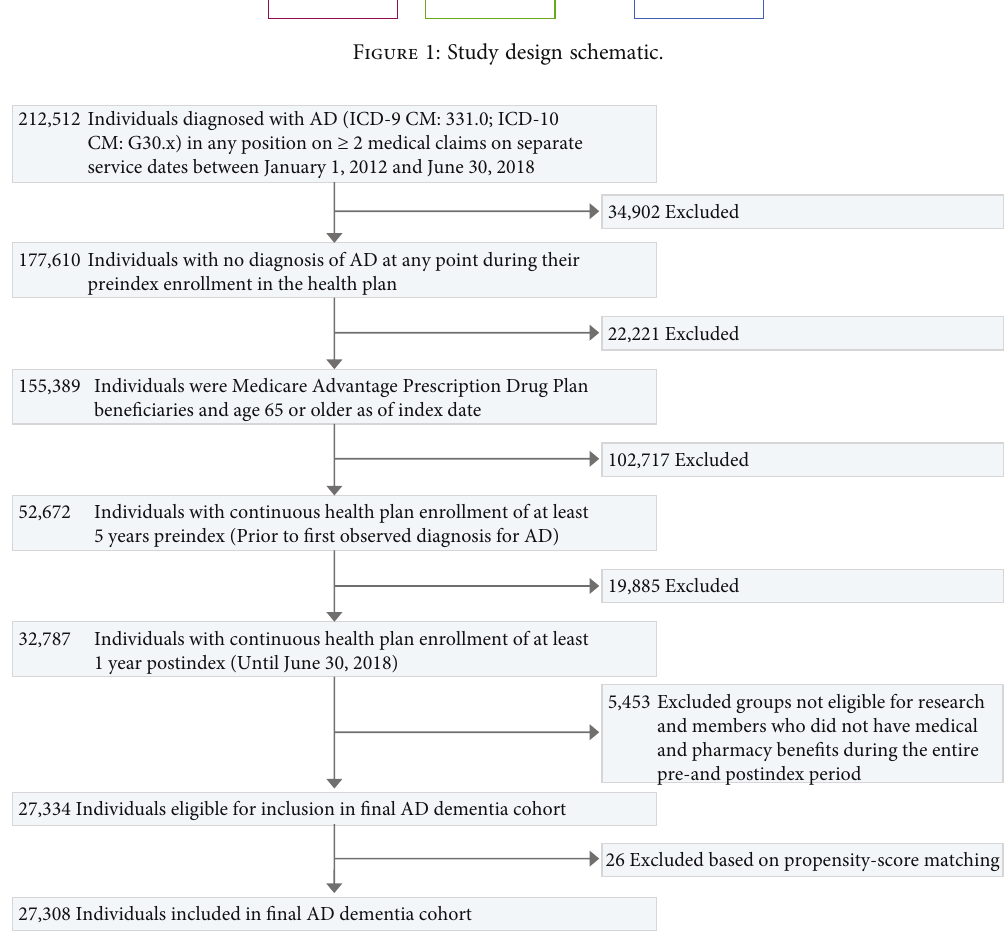
Figure 2: Attrition diagram for the AD dementia